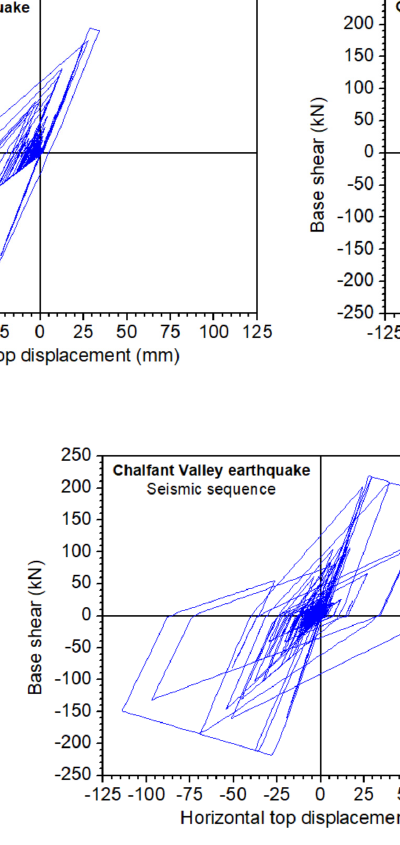
Figure 9. Soil – pile – platform system under the Chalfant Valley earthquake (20 – 21 July 1986): single seismic events vs. seismic sequence.